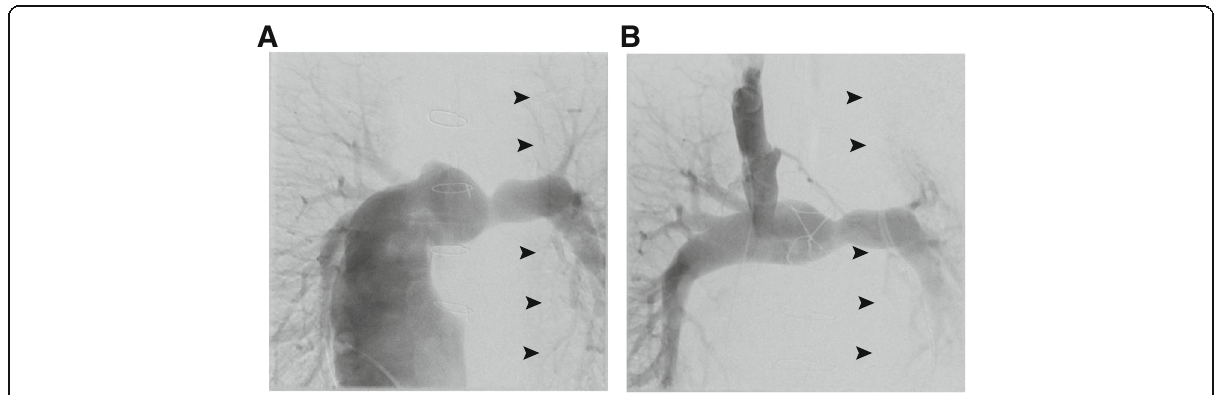
Fig. 2 Pulmonary angiograms of a before and b after the TCPC conversion showing reduced blood distribution to left lung due to the left hemidiaphragmatic paralysis following the TCPC conversion surgery